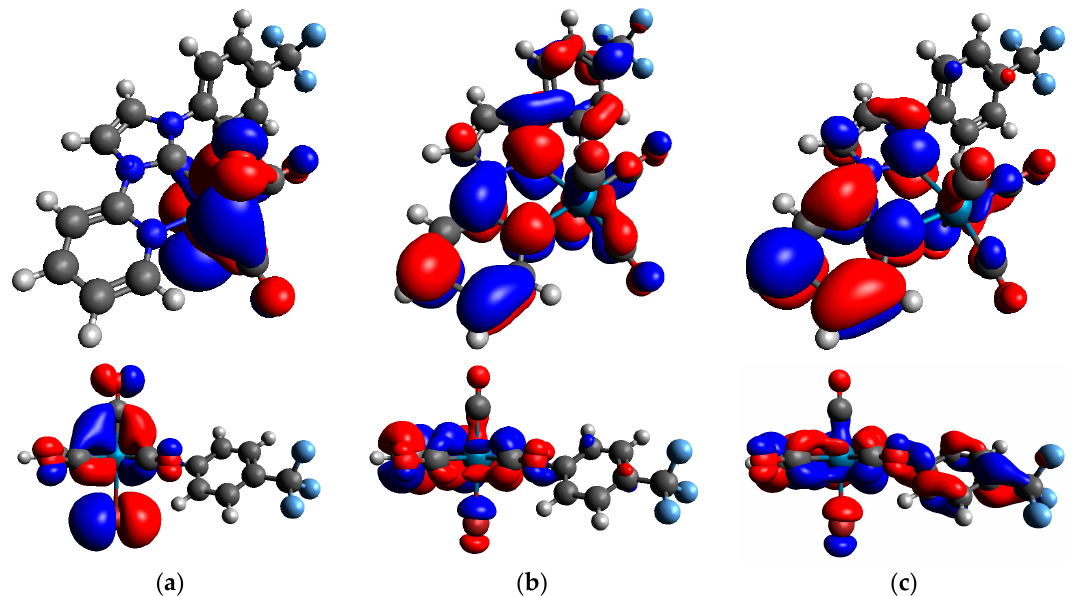
Figure 3. Re(pyNHC-PhCF 3 )(CO) 3 Br ( a ) HOMO, ( b ) LUMO and ( c ) single occupied molecular orbital (SOMO) images. Top row shows the ligand π -face primarily, and the second row shows the Re centered with the ligand on edge in back.